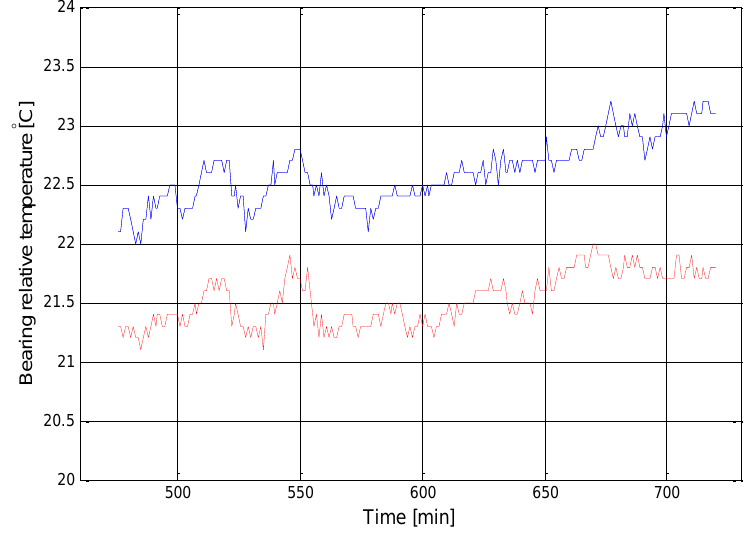
Figure 2. Processed bearing performance degradation data.